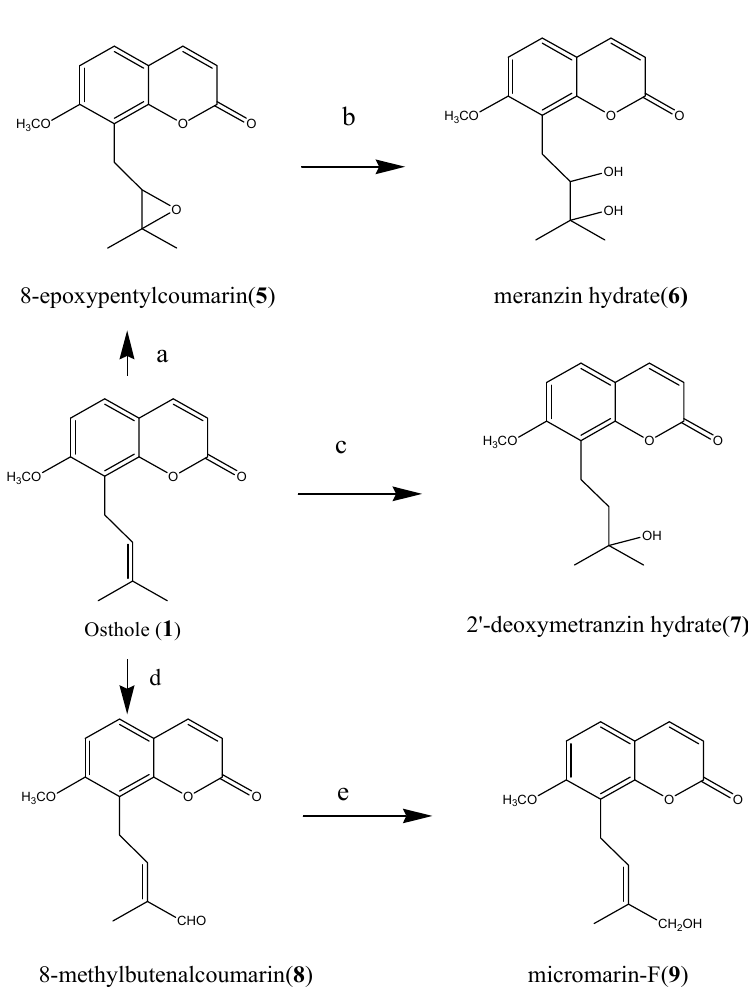
Cl , 0 °C; ( b ) H SO , THF-H O, room temp; 2 2 2 4 2 O, room temp; ( d ) SeO , DMSO-EtOH, reflux; ( e ) sodium 2 2